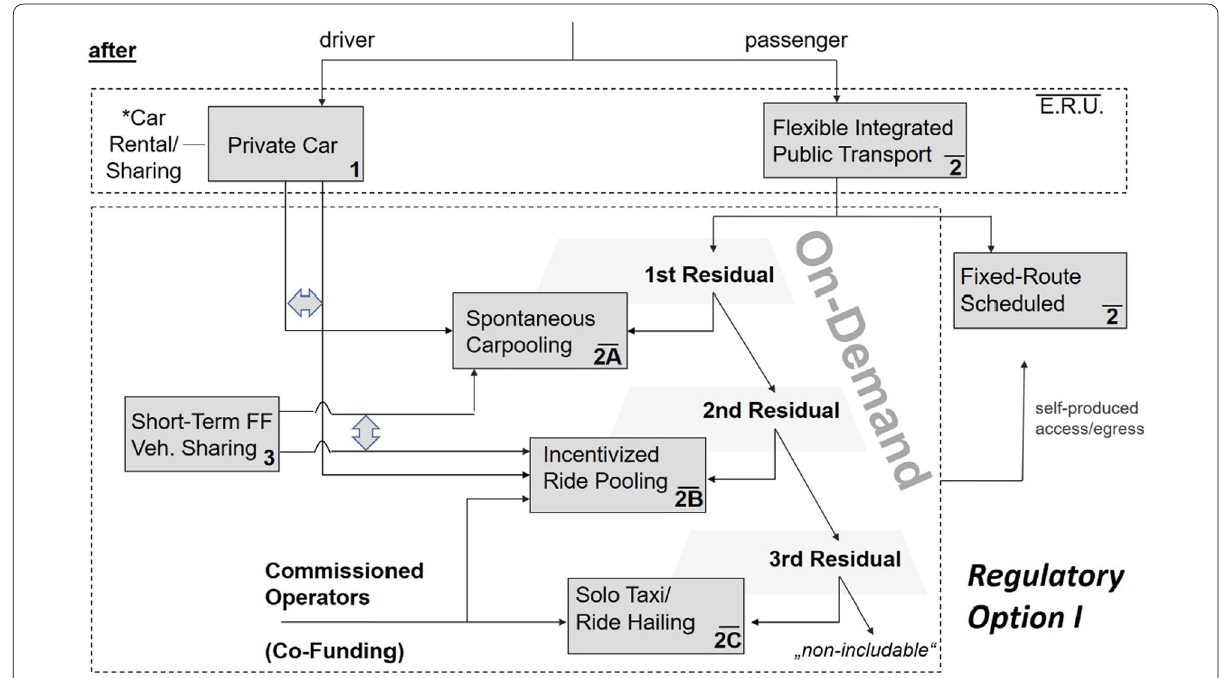
Fig. 1 Sequential choice set formation while pursuing regulatory option I